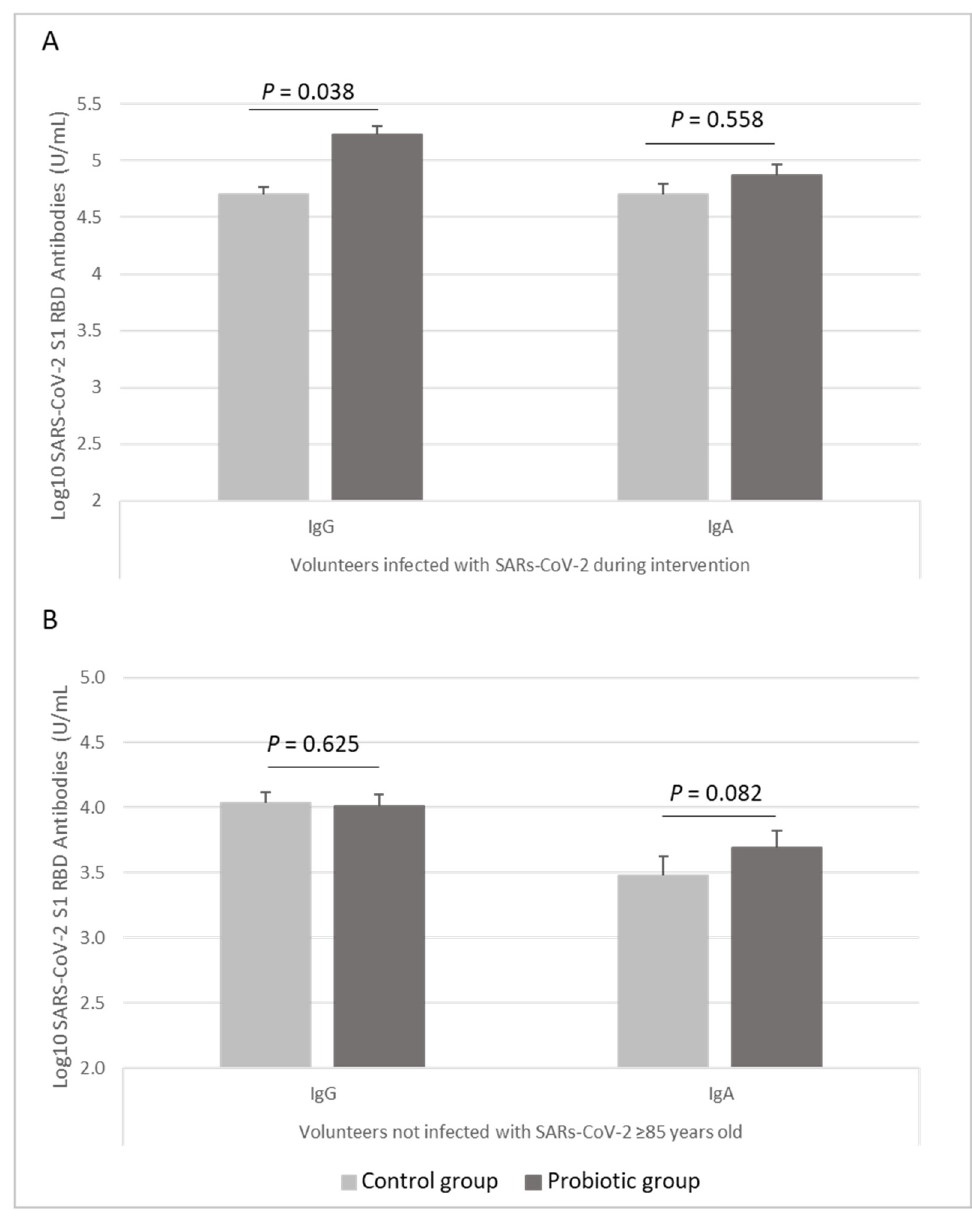
Figure 2. Levels of SARS-CoV-2 S1 RBD IgG and IgA antibodies (represented in Log10 of U/mL) in ( A ) volunteers infected with SARS-COV-2 during intervention ( n = 10 in the probiotic group, n = 6 in the control group) and ( B ) volunteers not infected with SARS-CoV-2 older than 85 years old ( n = 40 in the probiotic group, n = 48 in the control group). Data are represented as mean (bars) and SE (vertical lines). p value indicated differences between probiotic group (dark grey bars) and control (light grey bars) groups (univariate models adjusted by age, sex, disease index, and time to Covid-19 symptom’s resolution in Covid-19-infected subjects and adjusted by sex, disease index, and glucocorticoids in uninfected subjects).